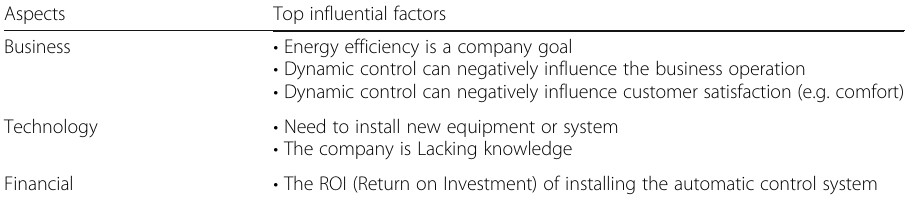
Table 4 Top Influential factors and the correspondent aspects Aspects Top influential factors